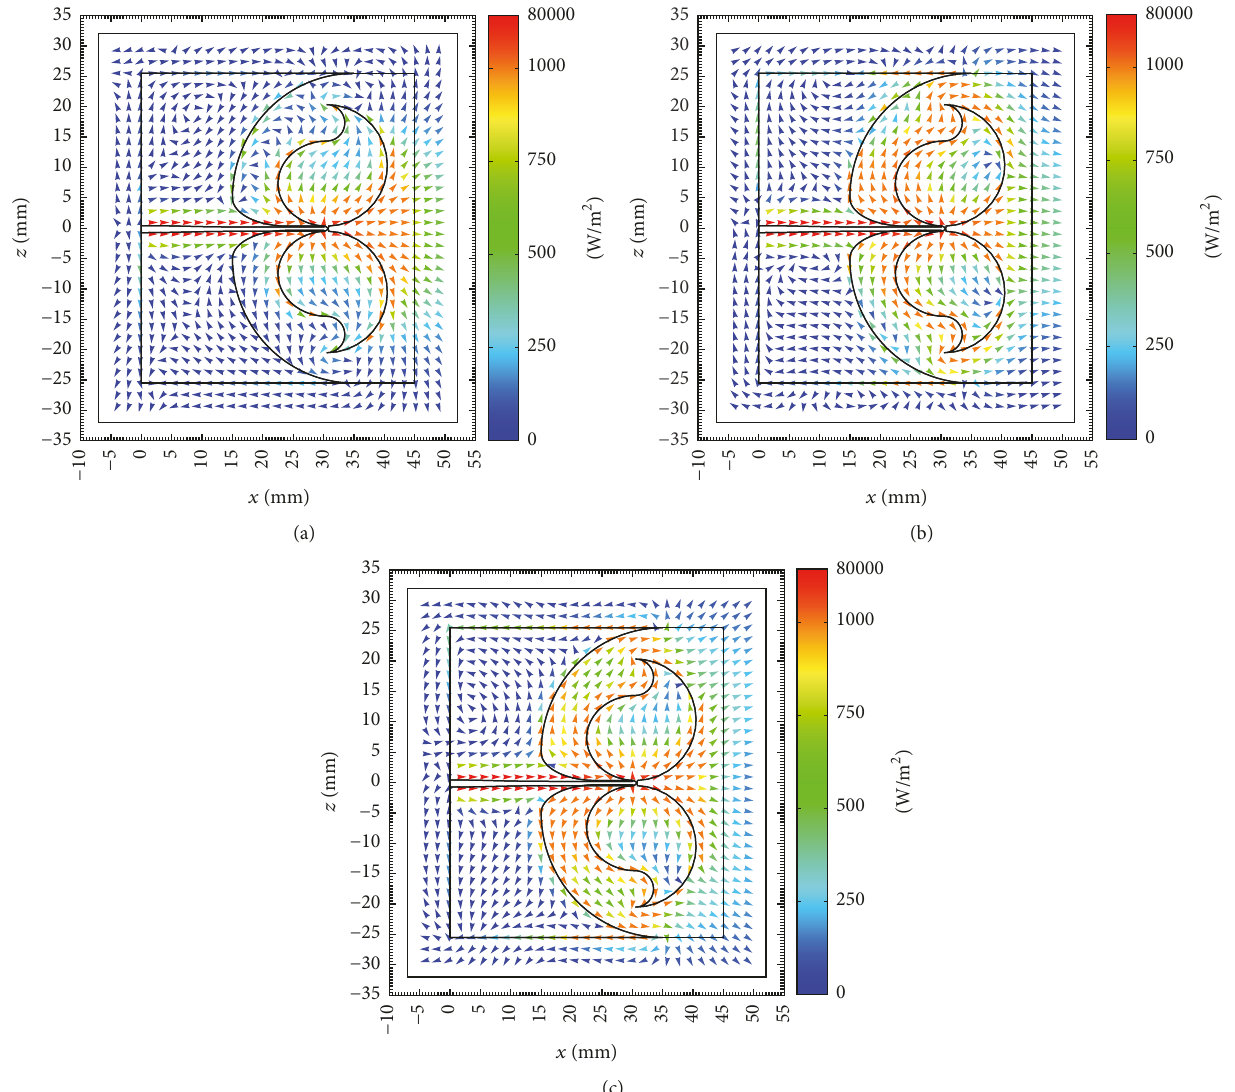
Figure 11: Spatial distribution of the real part of the Poynting vector in the 𝑥𝑧 -plane at the air-dielectric interface. Working frequency (a) 𝑓 = 5 GHz, (b) 𝑓 = 6 GHz, and (c) 𝑓 = 7 GHz. An interesting guiding effect of the electromagnetic energy along the back-side contour of the antenna arms and a quasi-traveling field behaviour enhanced by the metal reflector is observed in the radiated power density flux at the frequency of 𝑓 = 6